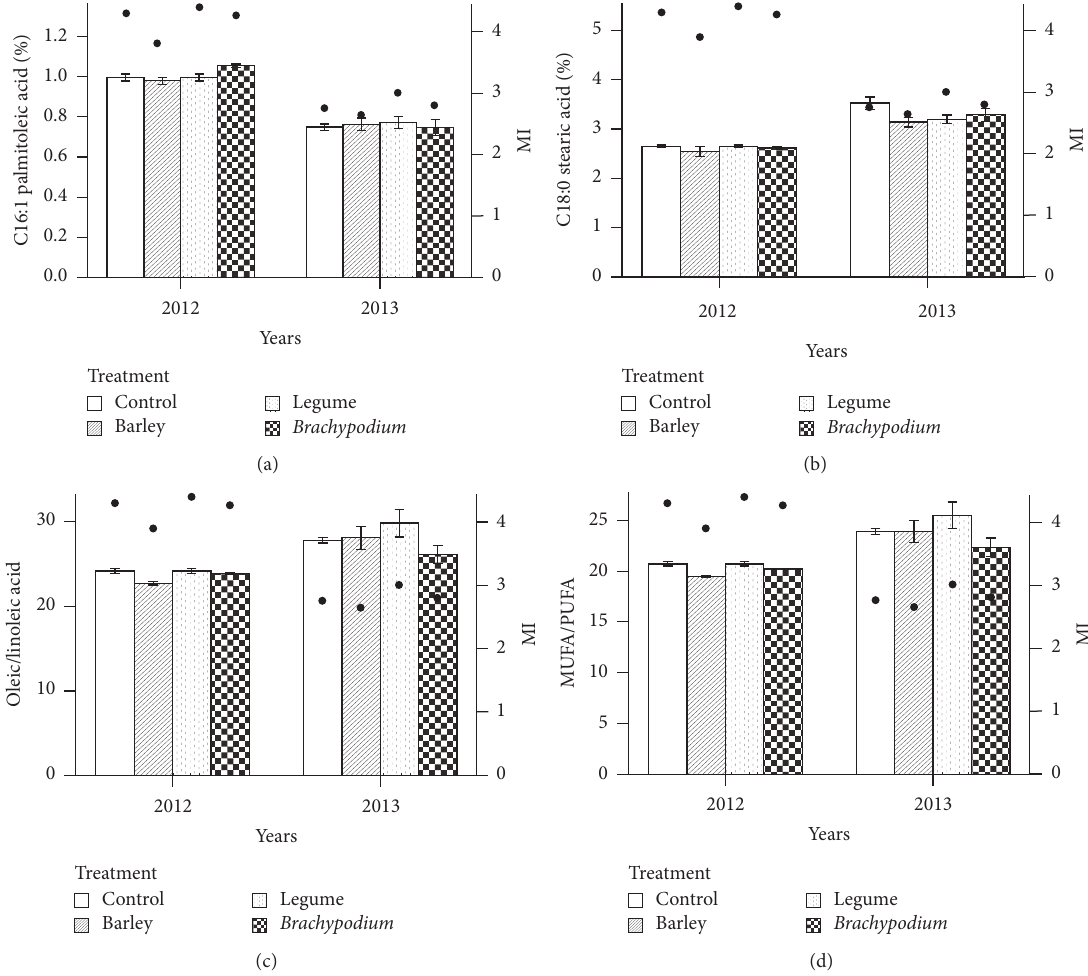
Figure 5: Palmitoleic (a) and stearic (b) acids, oleic to linoleic (c) acids, and MUFA to PUFA (d) ratio mean and standard deviation and maturity index (MI) as dots of different treatments and